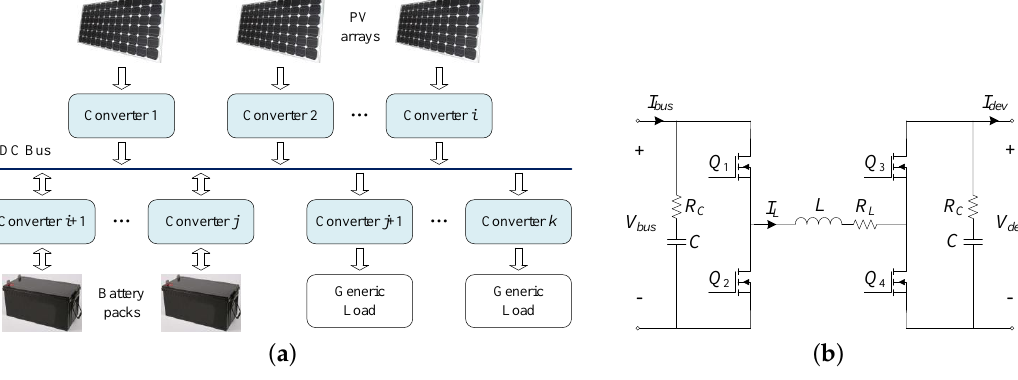
Figure 1. ( a ) Architecture of the standalone DC microgrid. ( b ) Power stage of the adopted bidirectional non-inverting buck-boost